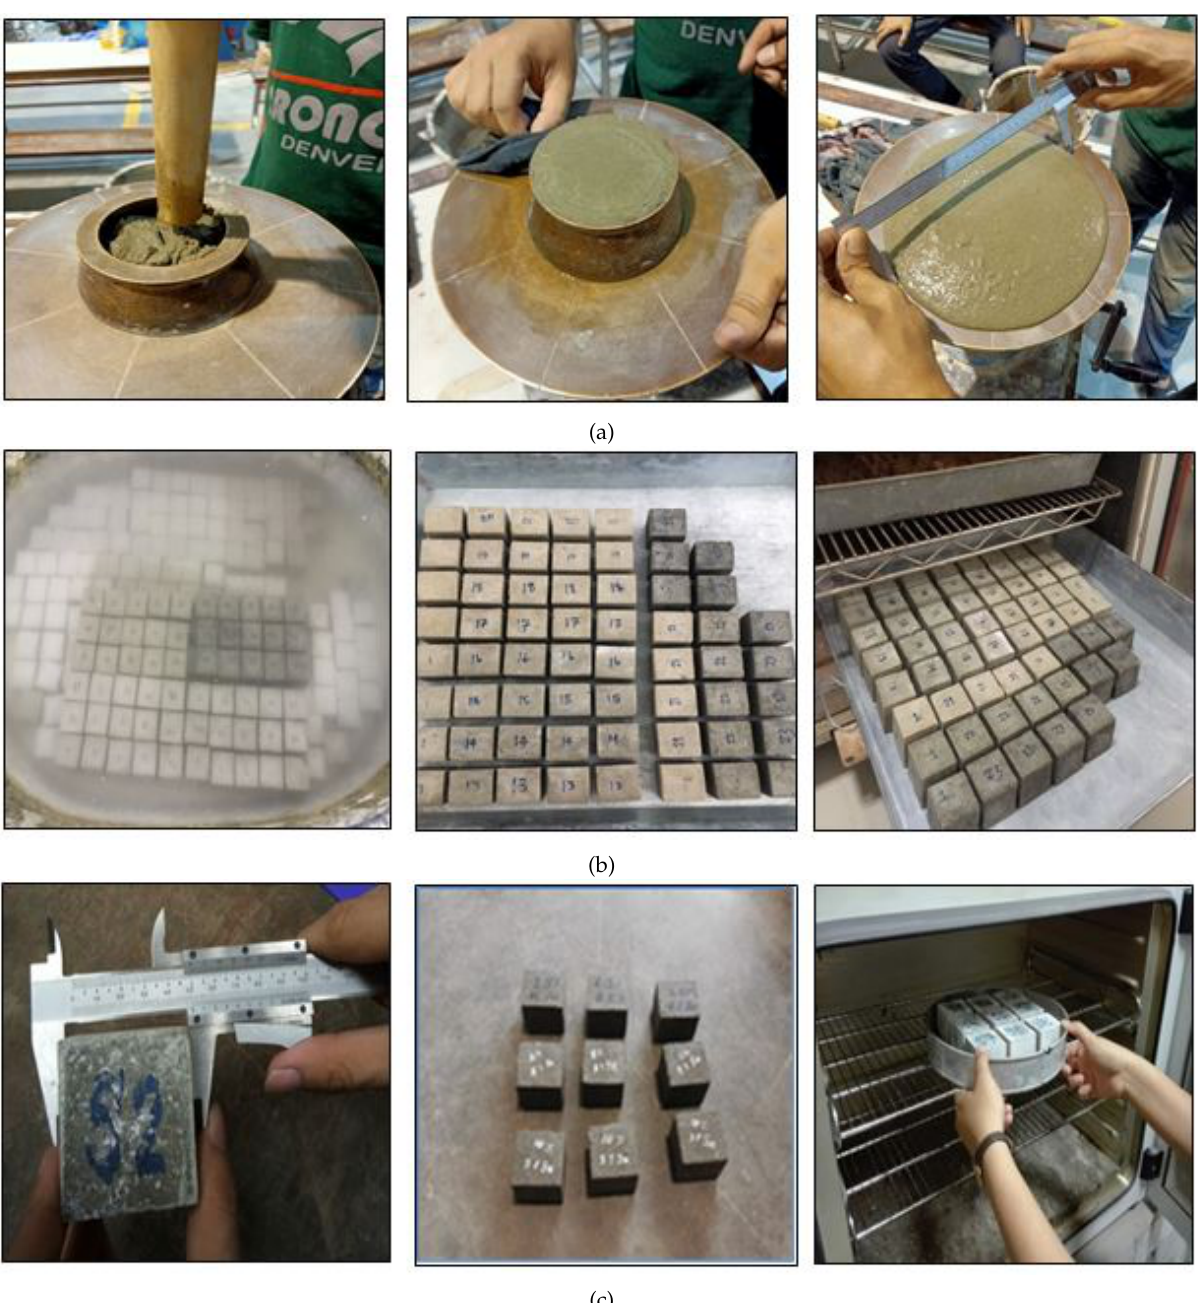
Fig. 3. Physical properties test of mortars. (a) Flow table test; (b) Water absorption test; (c) Dry bulk